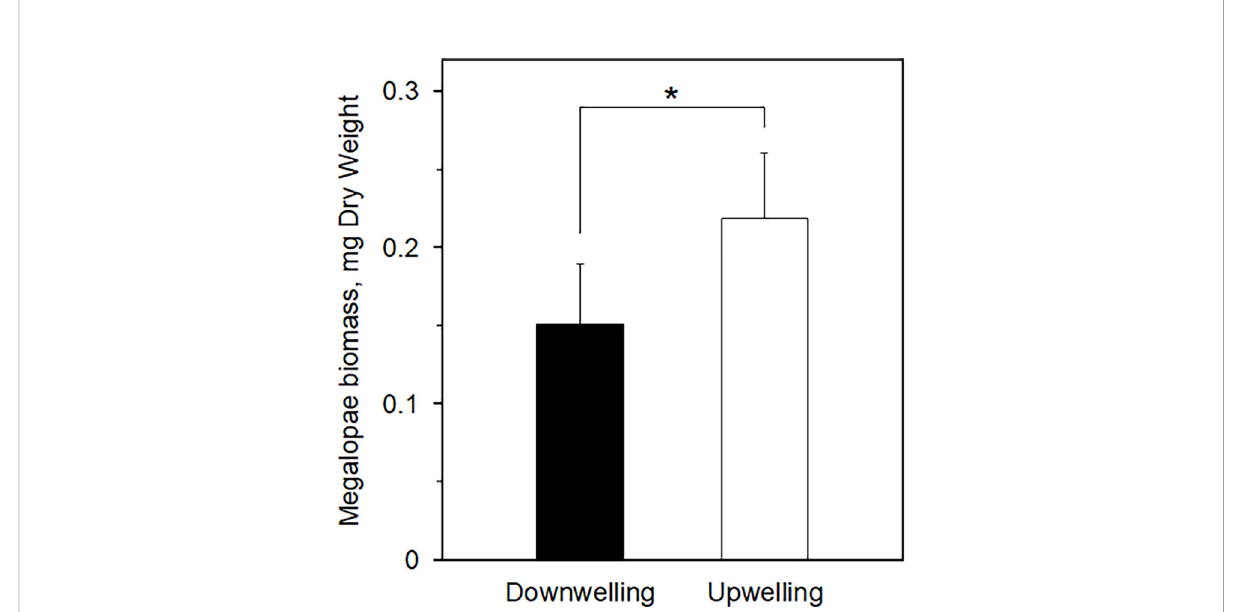
FIGURE 3 Biomass of Carcinus maenas megalopae (mg DW) collected during downwelling ( n = 226) and upwelling ( n = 307) conditions. The * denotes signi fi cant differences between supply events (one-tailed Students ’ t-test, p = 0.00).